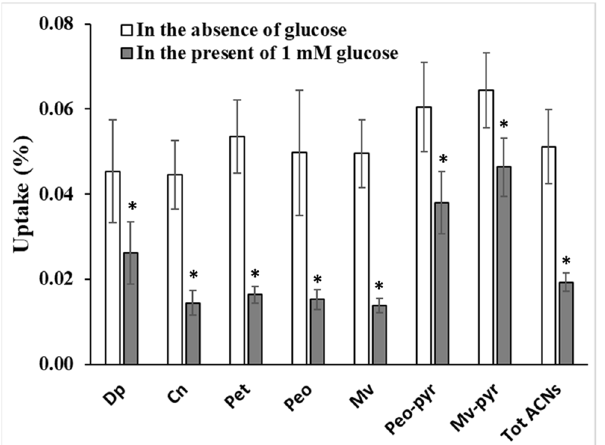
Figure 5. The influence of 1 mM glucose on the uptake of red grape anthocyanins by Caco-2 cells. Dp (delphinidin-3-glucoside), Cn (cyanidin-3-glucoside), Pet (petunidin-3-glucoside), Peo (peonidin-3-glucoside), Mv (malvidin-3-glucoside), Peo-pyr (peonidin-3-glucoside pyruvic acid), Mv-pyr (malvidin-3-glucoside pyruvic acid), Tot ACNs (total anthocyanins). * significant at p < 0.05 .